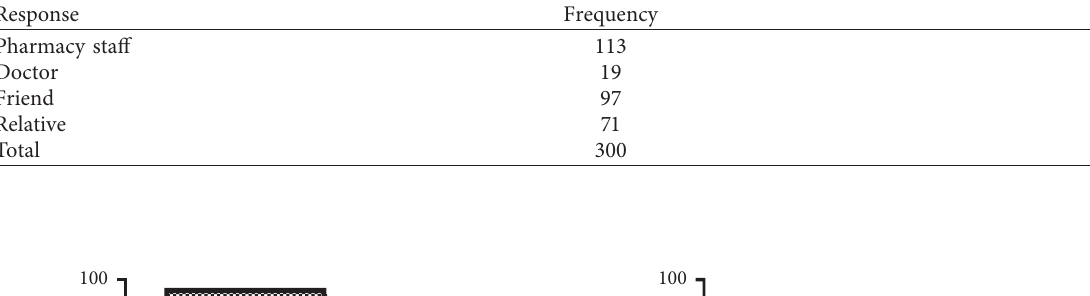
Table 2: Respondents’ sources of information about medication.